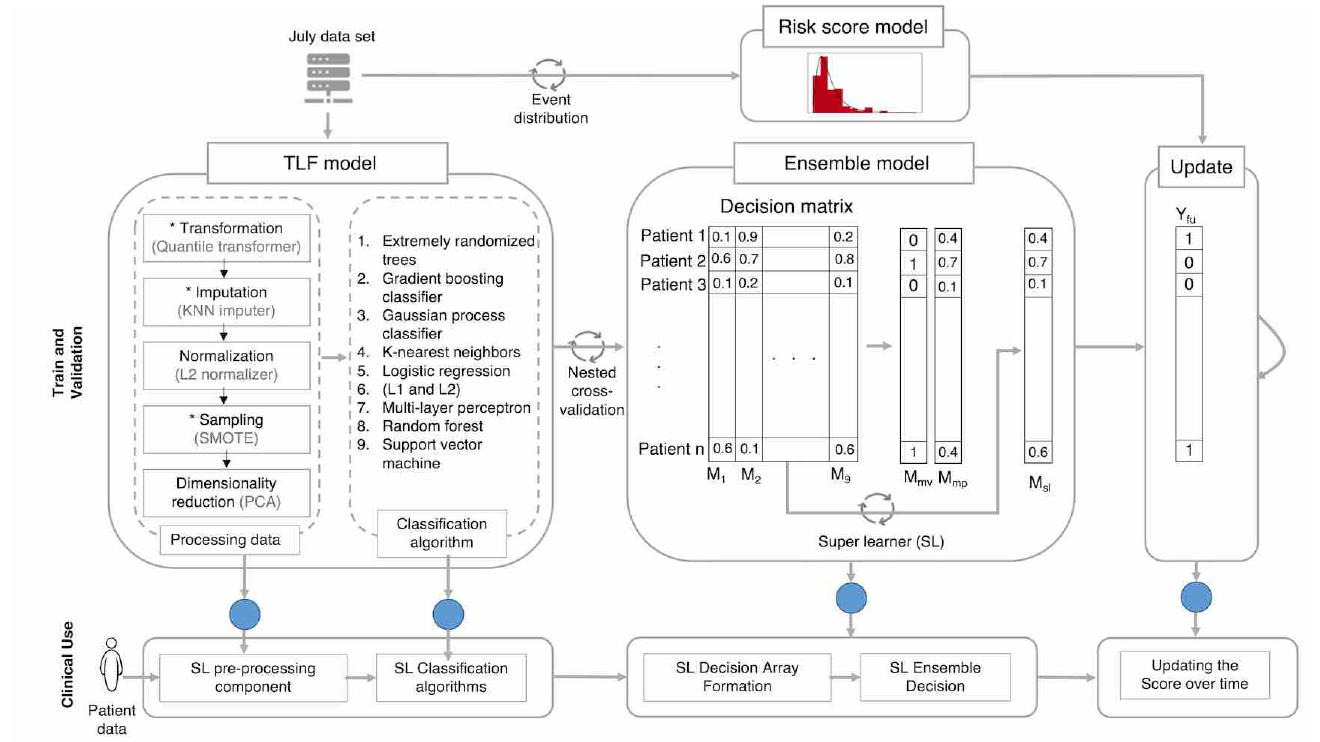
Figure 2. Model architecture and its main components for when the model is being trained and validated ( top ), and when in use in clinics ( bottom ). The model deployed in clinics requires minimal computation power and resources, since it only requires the final trained parameters of the system (blue circles). Only at the beginning do we require above-average computation power to train and validate the